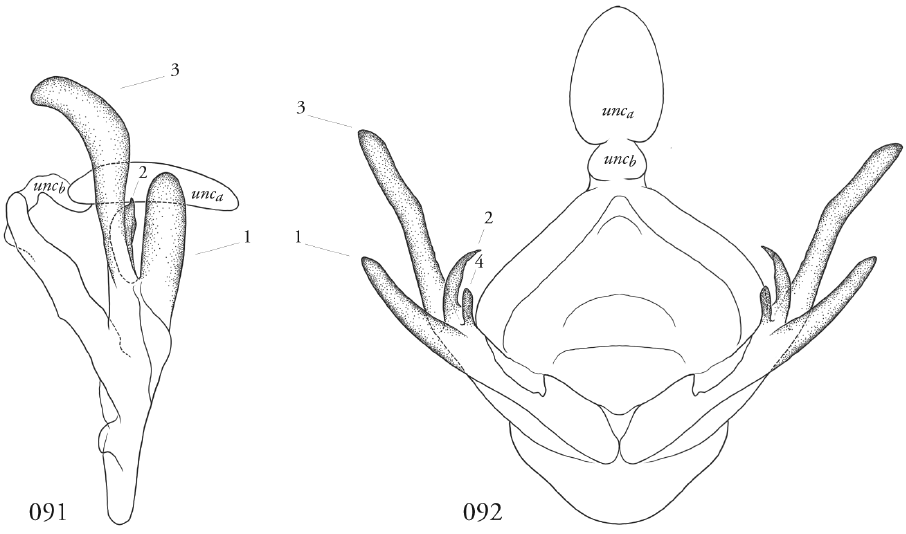
Figures 91, 92. Lomphomyra tacita male terminalia. Área de Conservación Guanacaste (ACG), Costa Rica, 10-SRNP-70435, USNMENT01437276, USNM Dissection 148202. 91 Lateral 92 Caudal. Numbers refer to structures as enumerated in text: 1 = sacculus; 2 = clasper; 3 = cucullus; 4 = ampulla-like